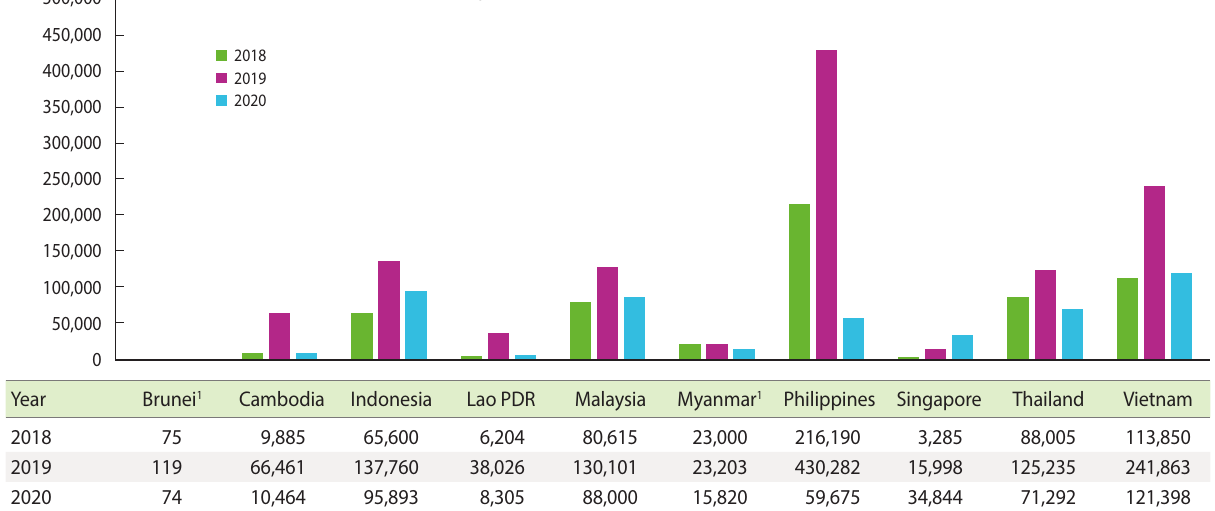
Figure 1. Comparison of dengue cases between 2018 and 2020 in several Associa tion of Southeast Asian Nations (ASEAN) countries; Sin- gapore reported higher cases of dengue in 2020 (during the pandemic), while others have shown decrease as compared to the dengue epidemics in 2019. 1 Data is